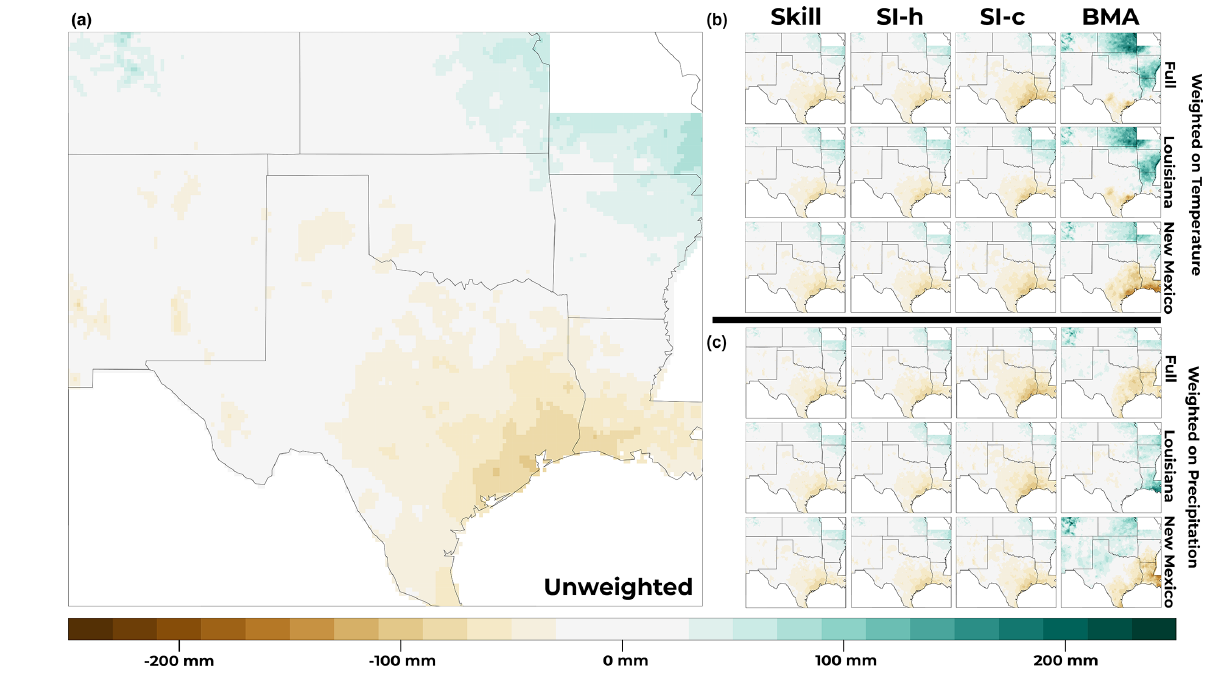
Figure 12. Same as Fig. 9, but for the mean projected change in precipitation from the LOCA